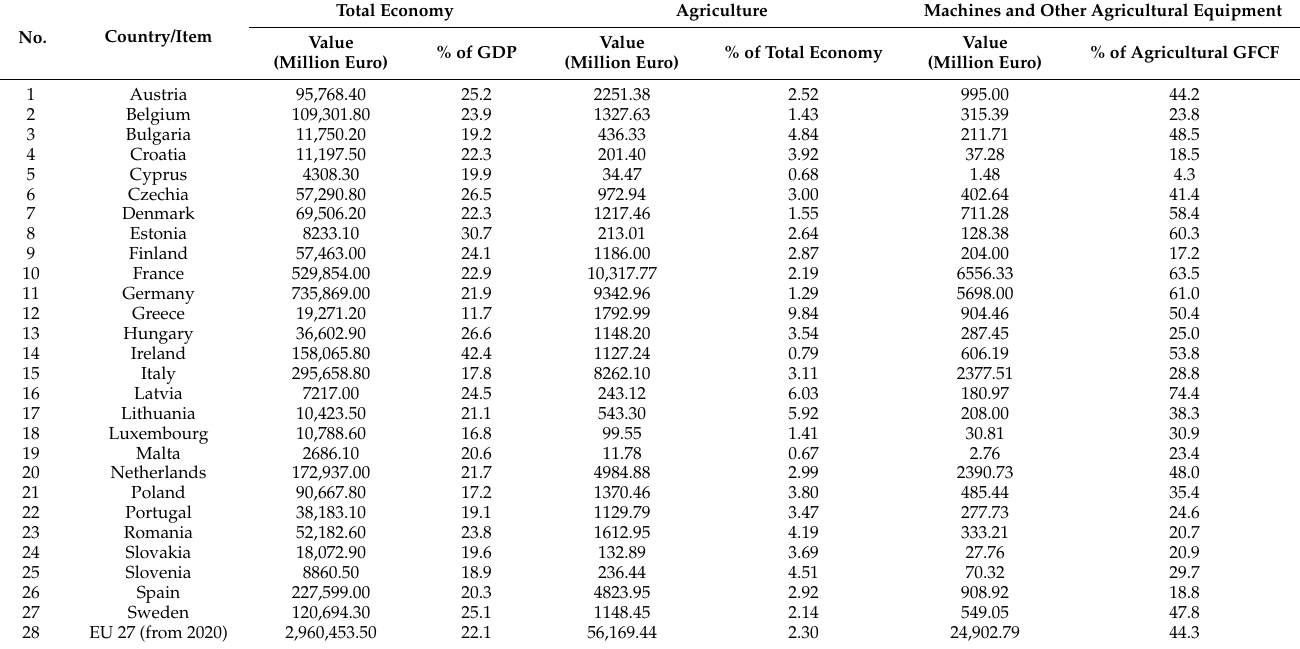
Table 3. Gross fixed capital formation-EU,